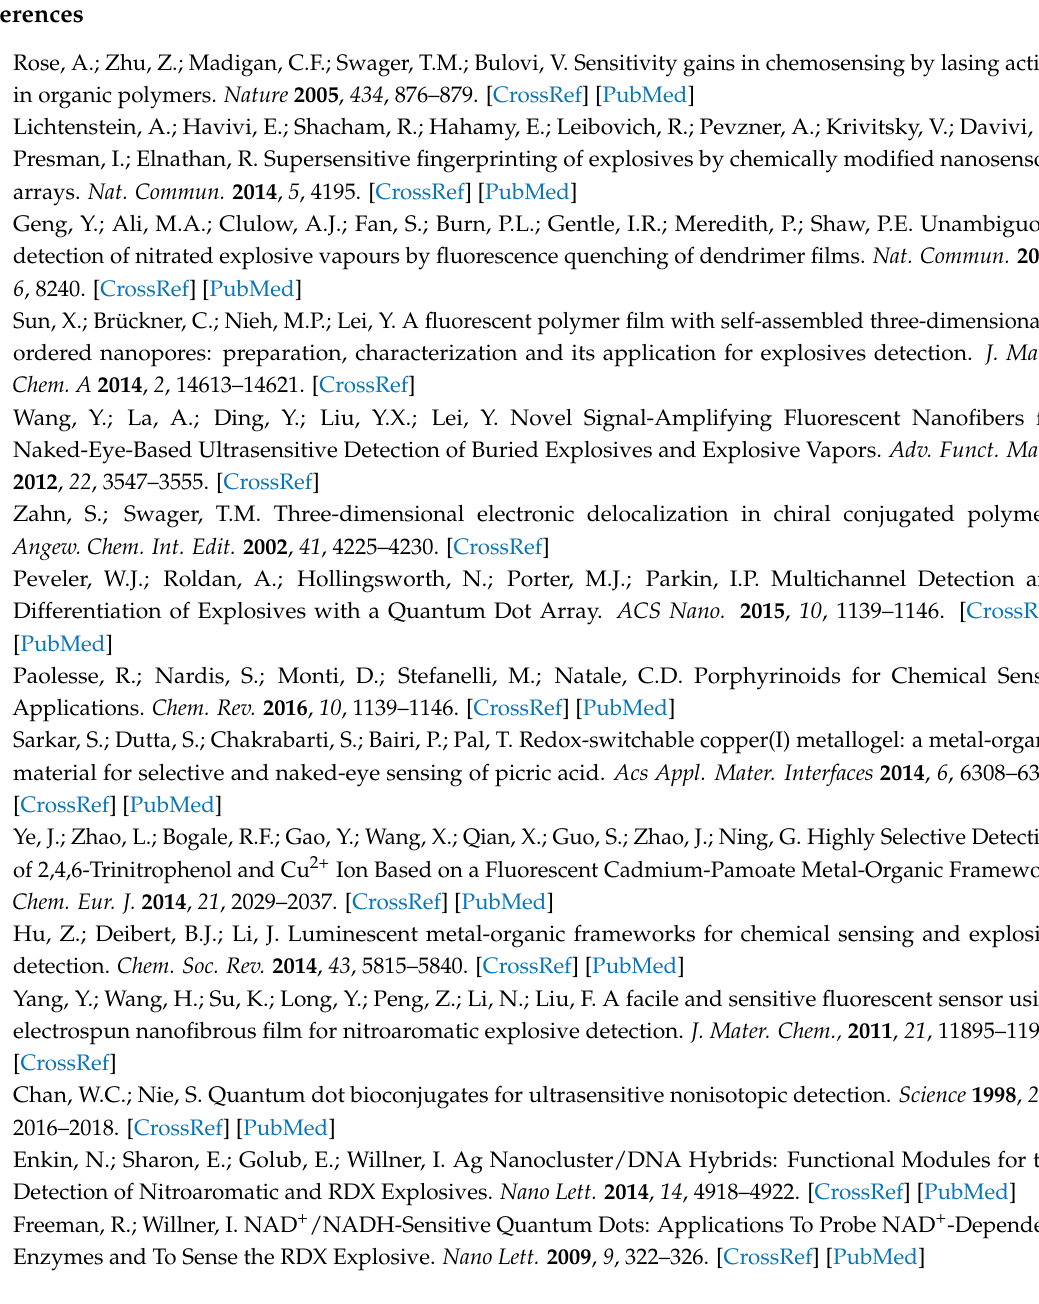
membrane, the inset in (b) shows image of water drops and the corresponding contact angles, Figure S4: Schematic diagram of ZnS QDs loading on nanofiber surfaces, Figure S5: Reproducibility of the quenching sensitivity of the nanofibrous membranes, Figure S6: Time-dependent fluorescence curves of the sensing array based on fluorescent membranes towards saturated TNT, DNT and PA vapors at room temperature, Figure S7: Time-dependent fluorescence curves towards the saturated NB vapor at room temperature (a) PU-1C, (b) PU-1CH, (c) PU-1L and (d) PU-1TL, Figure S8: Structural formula of TNT, PA, DNT and